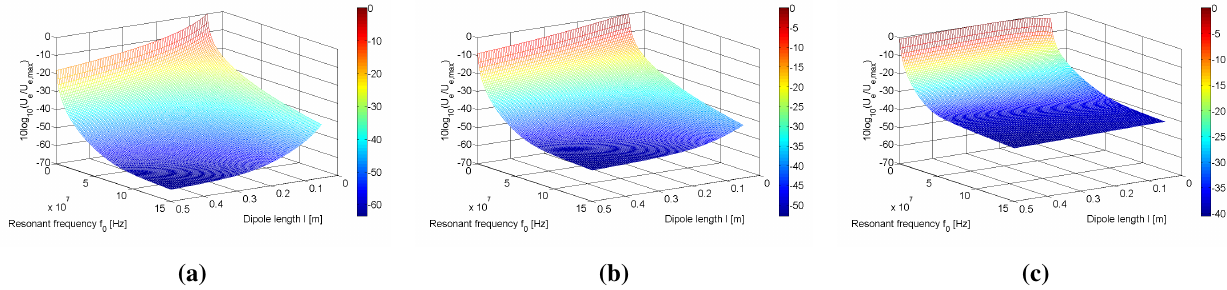
Figure 7. Variation of the figure of merit U frequency f and dipole length l for (a) d = 0 . 01 m, (b) d = 0 . 1 m and (c) d = 0 . 5 m for the 0 parallel